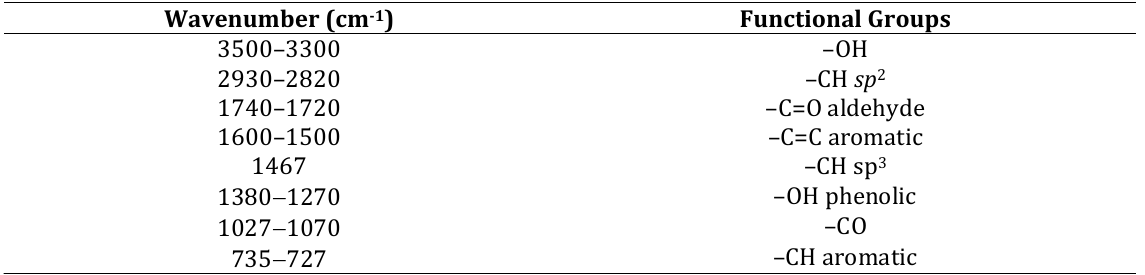
Table II. The identified functional groups in S. arvensis leaves